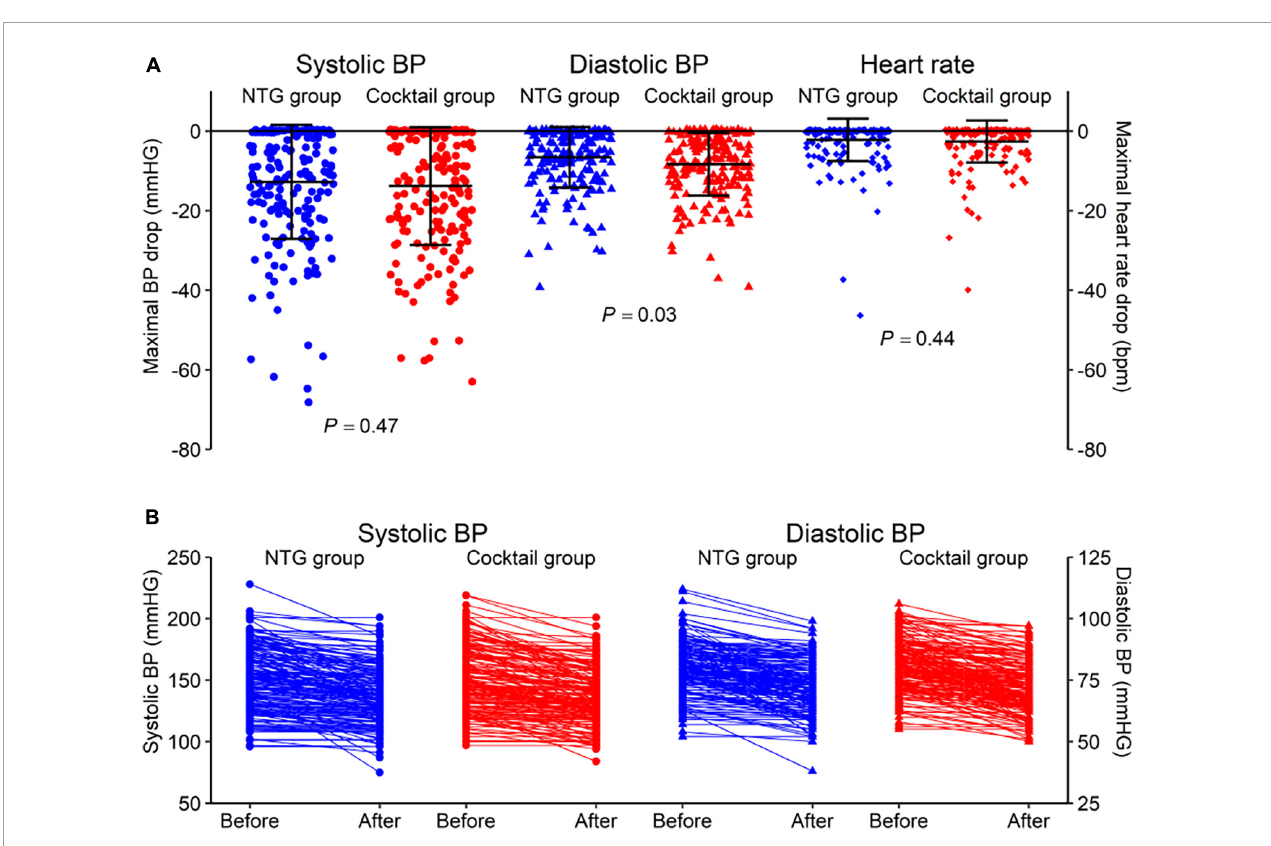
FIGURE3 (A) Comparison of changes in vital signs including systolic and diastolic blood pressure and heart rate between the NTG and cocktail group. (B) Changes of systolic and diastolic blood pressure in NTG and cocktail